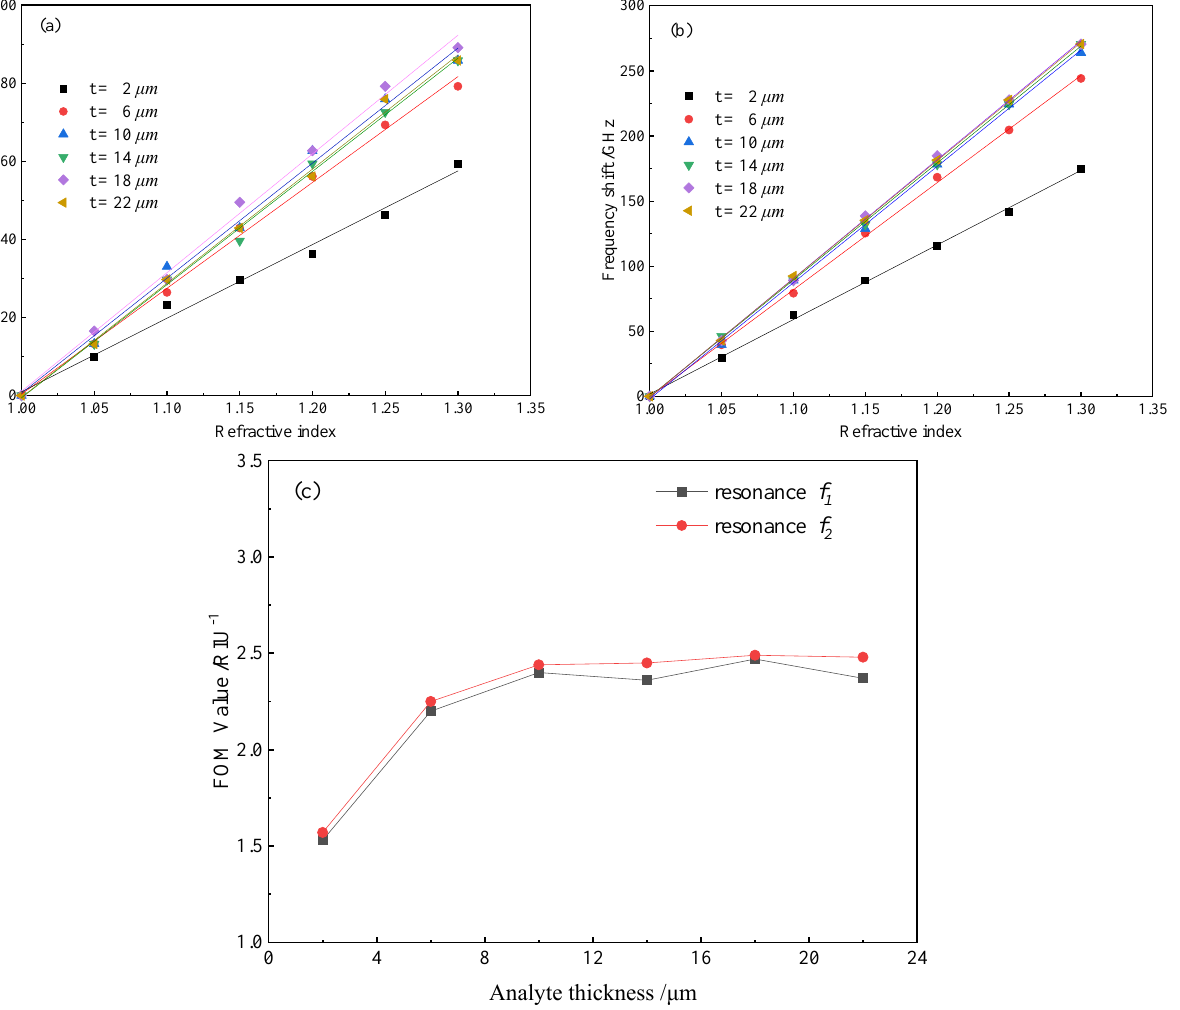
Figure 5. Resonant frequency shift of the sensor as a function of refractive index with different thicknesses of analyte and the linear fitting results at ( a ) f 1 and ( b ) f 2 ; ( c ) influence of the analyte thickness on the FOM values.